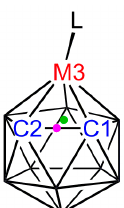
Figure 6. The orientation of the ligand L is defined by the modulus of the torsion angle θ where θ = L − M3 − A − B ; A is the centroid of the metal-bound C 2 B 3 face (green dot) and B is the centroid of the C1 − C2 bond (purple dot).